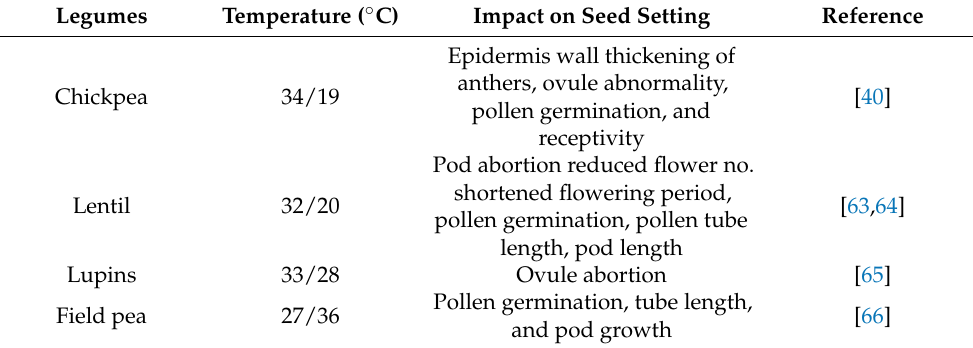
Table 3. Impact of high temperature on seed setting of cool-season food